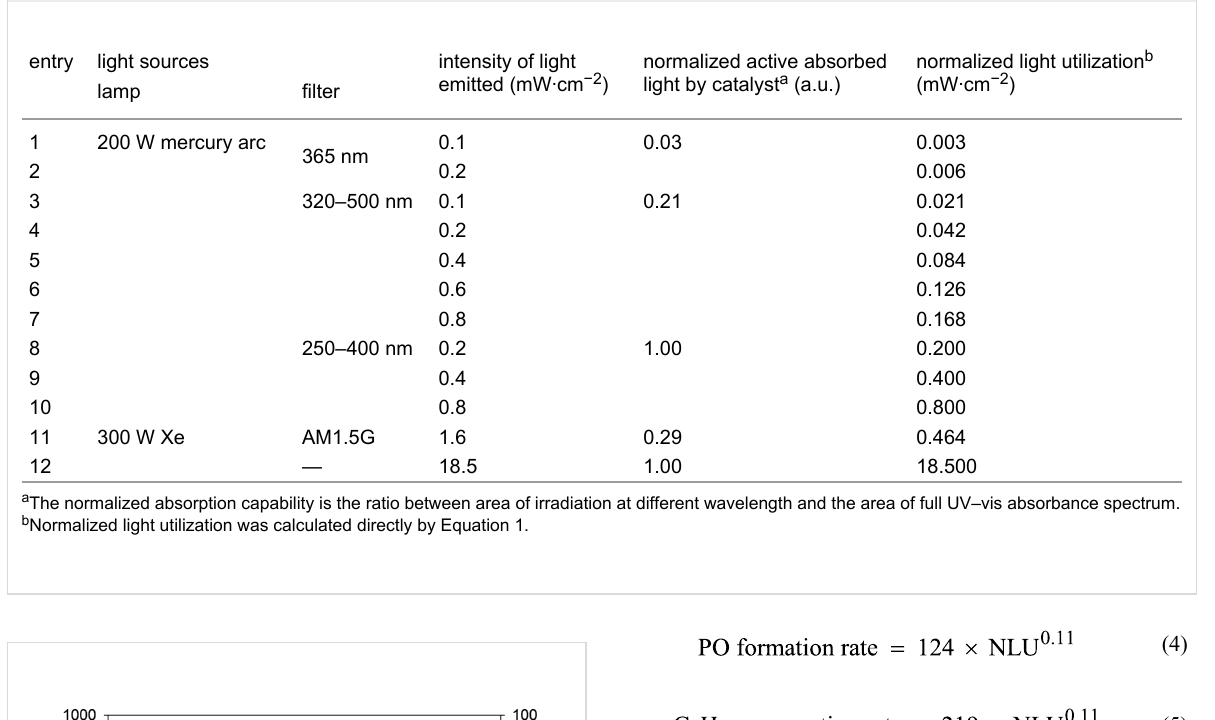
Table 2: A quantitative evaluations of normalized light utilization by V-Ti/MCM-41 photocatalyst.